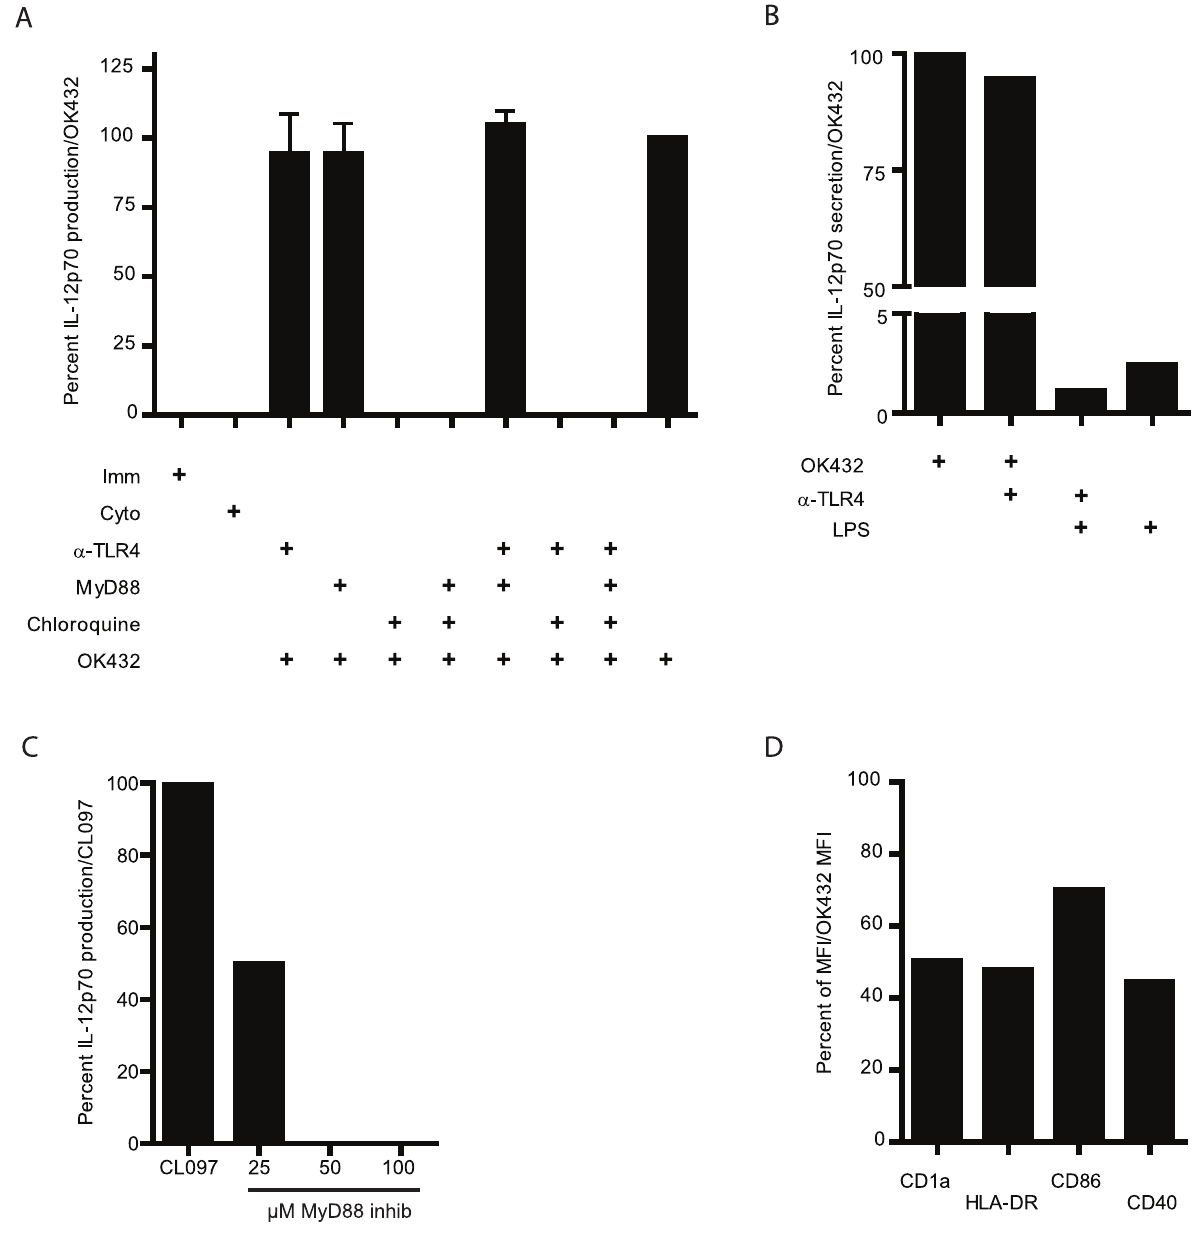
Figure 1. Chloroquine treatment abolishes IL-12p70 production by DC stimulated with OK432. A) Combinations of blocking antibody to TLR4, MyD88 inhibitory peptide and chloroquine were used to decipher contributions of different TLR in IL-12p70 production by DC after OK432 stimulation. The DC were pre-treated with the indicated compounds for 30 minutes at 37 u C before maturation was induced by OK432. Immature DC were given only IL-4 and GM-CSF and Cyto were stimulated with the Jonuleit cytokine cocktail (IL-1 b , IL-6, TNF- a and PGE 2 ). Only treatment with chloroquine reduced the level of IL-12p70 produced after OK432 stimulation. Mean + SEM is shown for 4 donors. B) To verify the effect of TLR4 blockade, a blocking antibody against TLR4 was used at 9 m g/ml. This reduced the level of LPS (20 ng/ml) induced IL-12p70 production by 50%. Mean of n=2. C) MyD88 inhibition effectively decreases CL097 mediated IL-12p70 production via TLR7/8 signaling. D) Chloroquine has profound effects on the maturation status of OK432 stimulated DC. Percent MFI of CD1a, HLA-DR, CD86 and CD40 after pre-treating the DC with chloroquine before OK432 stimulation compared to OK432 alone (set to 100 percent) is shown. One representative experiment shown of three performed.